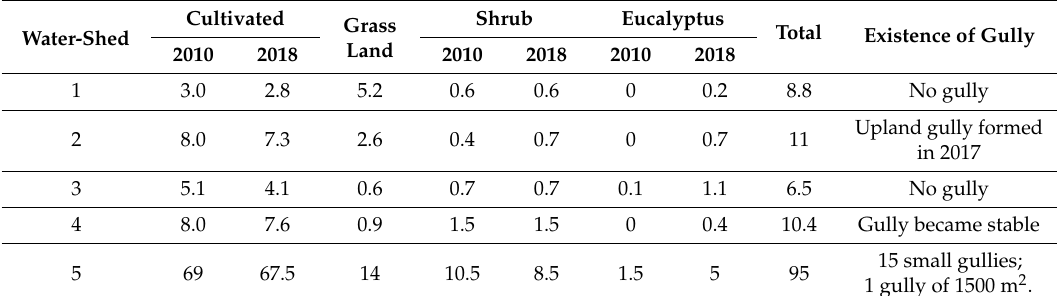
Table 1. The land cover acreage (ha) in Debre Mawi and nested sub-watersheds in 2010 and 2018. Grassland did not change, so only one value is given.